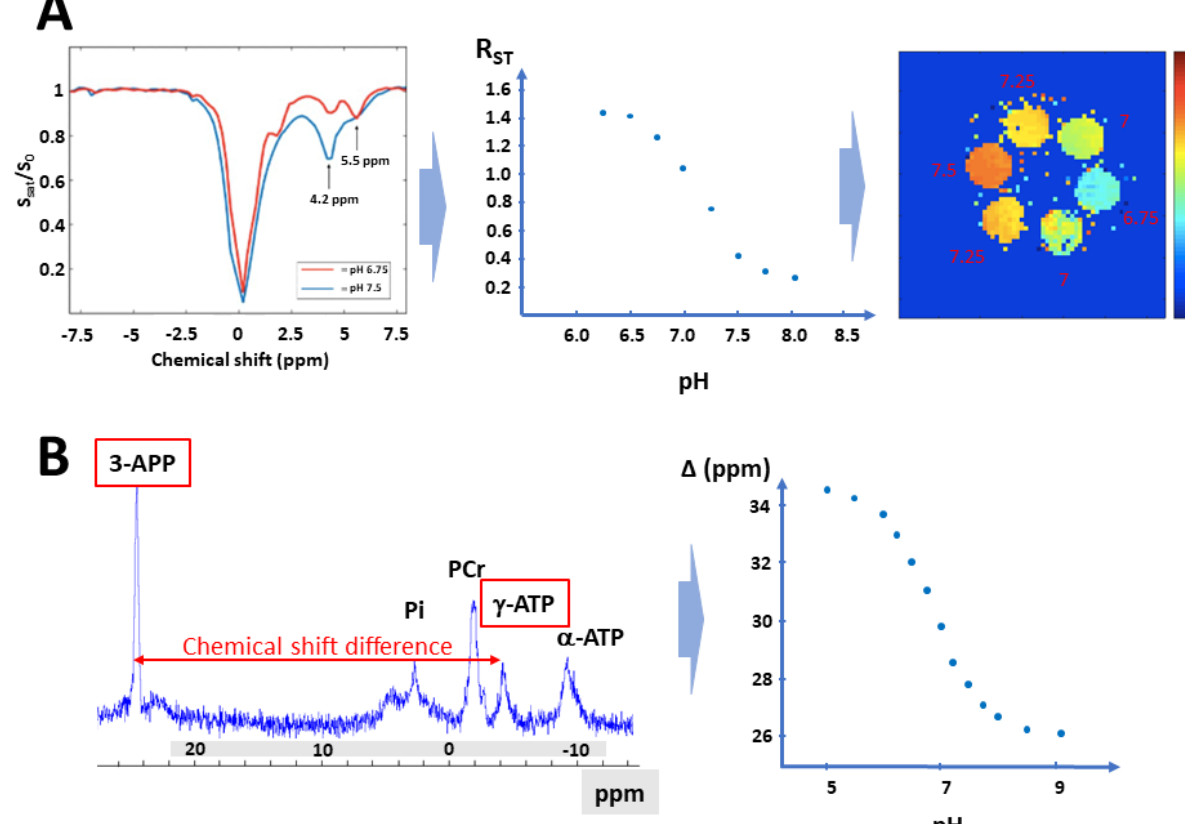
Figure 2. Principle of two popular MR methods to assess pHe. ( A ): CEST-MRI is based on the transfer of saturation from the exchangeable proton to the water proton reducing the MRI signal amplitude of water. Left: Z-spectrum: normalized water intensity (S/S 0 ) vs. off-resonance frequency of the saturating RF for iopamidol in buffered solutions at pH 6.75 and 7.5. Center: calibration of the saturation transfer as a function of pH. Right: the calibration of the saturation transfer as a function of pH provides parametric map of pH as illustrated in tubes equilibrated at different pH. ( B ): Left: typical 31 P-NMR spectrum recorded in a tumor. The pHe is estimated by measuring the difference in chemical shift between the signal coming from 3-APP used as extracellular pH reporter probe and the signal coming from on phosphorous present on ATP. Right: calibration of the difference in chemical shift between 3-APP and γ -ATP as a function of pH.